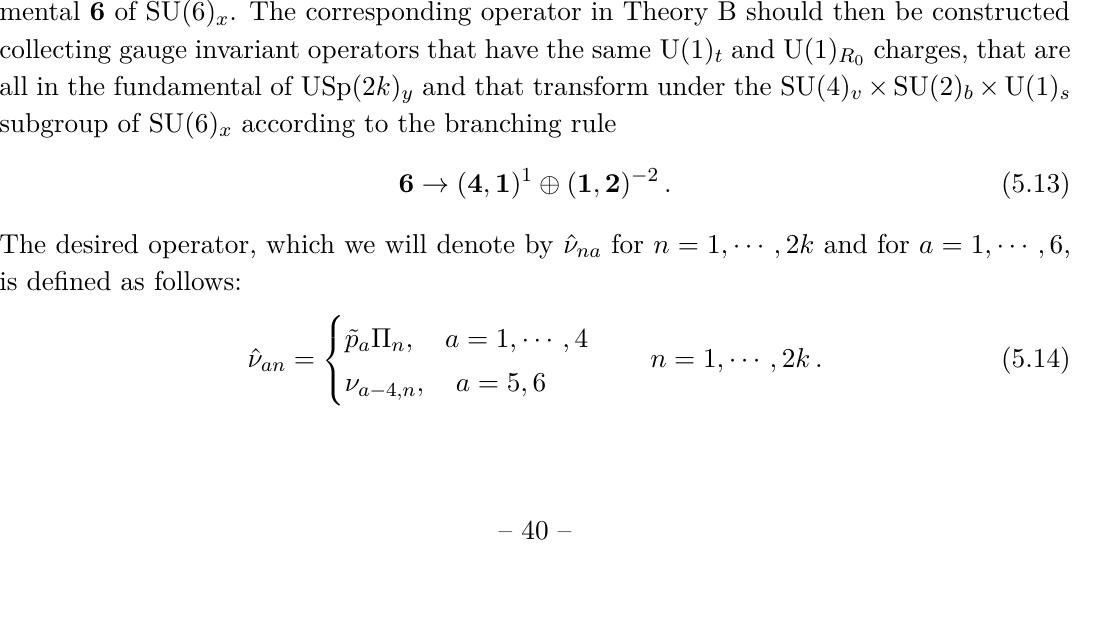
and U(1) , while their transformation properties t R 0